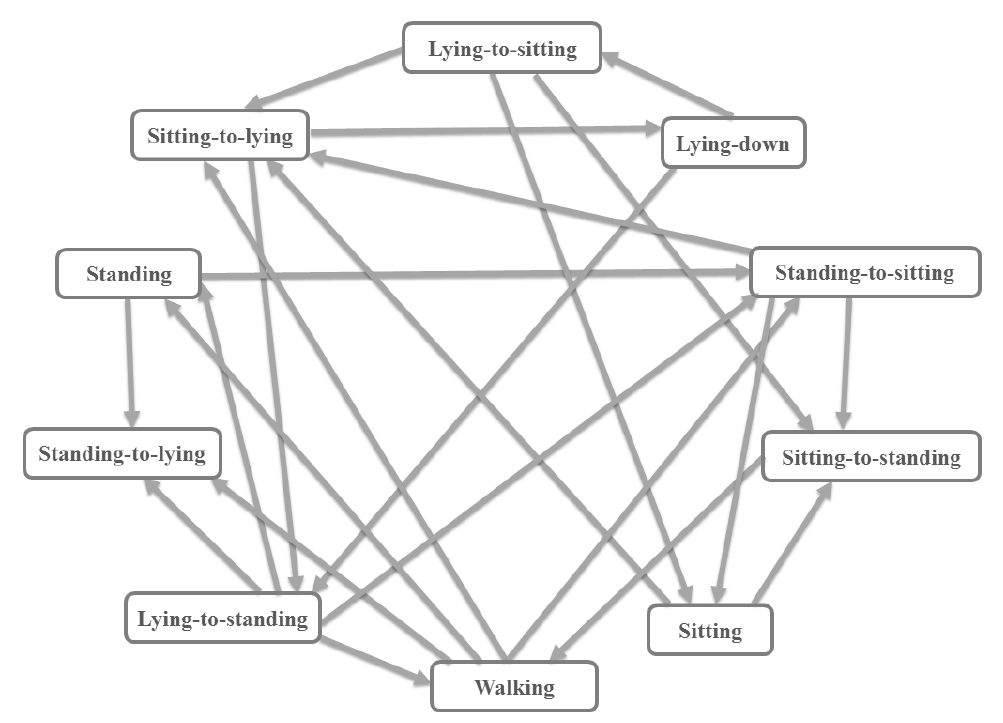
Figure 5. State machine of the logical filter with allowed connections between activity